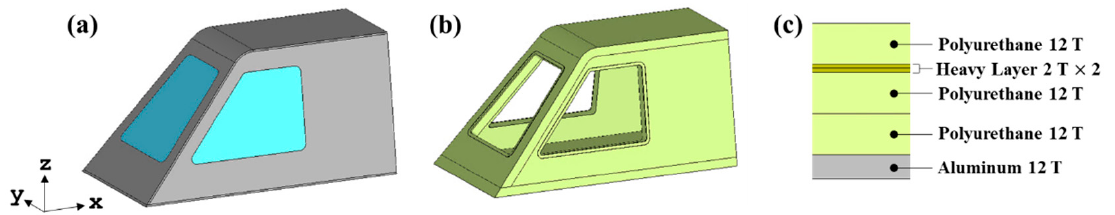
Figure 14. HSM for vibroacoustic computation: ( a ) glass windows and aluminum body panels; ( b ) sound absorption layers; ( c ) wall layers.